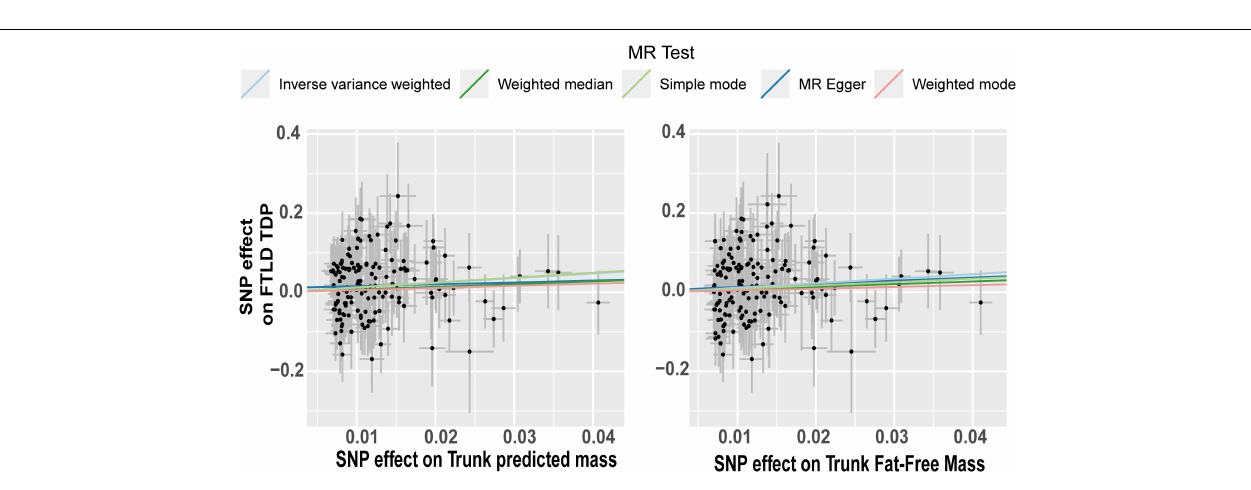
FIGURE 5 | Scatterplot of single nucleotide polymorphism (SNP) potential effects on trunk mass vs. frontotemporal lobar degeneration with TDP43. The slope of each line corresponds to the estimated Mendelian randomization (MR) effect per method. Significant changes in SNPs related to predict trunk mass and trunk fat-free mass are associated as a risk factor in FTLD TDP